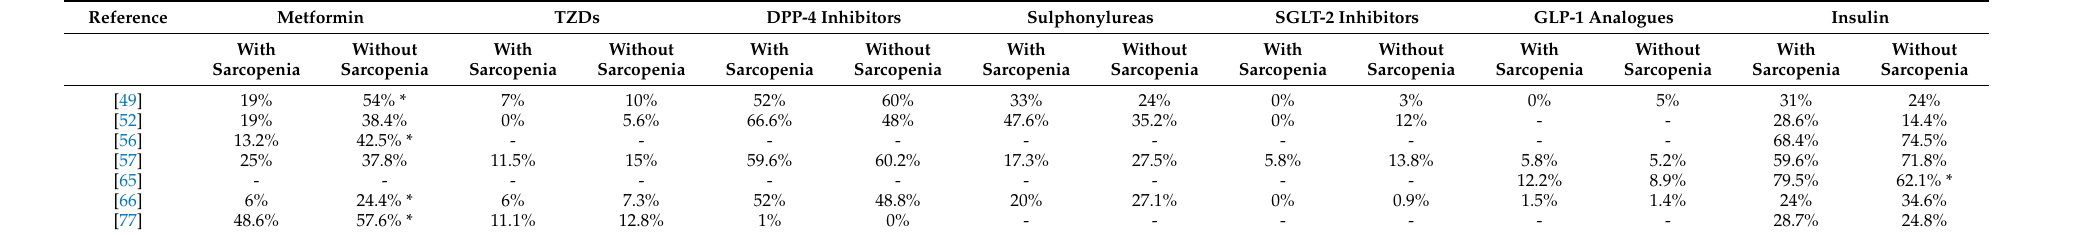
Table 3. Glucose-lowering drug utilization in type 2 diabetes mellitus individuals with and without